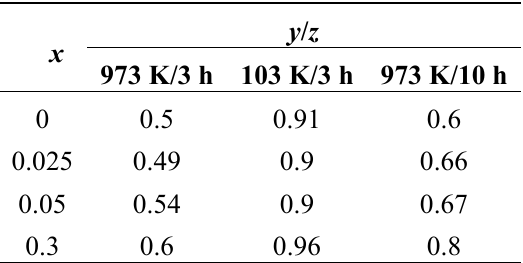
Figure 2. XRD patterns of the samples. ( a ) M10- x Cr-973 K/3 h; ( b ) M10- x Cr-1073 K/3 h; ( c ) M10- x Cr-973 K/10 h. Table 1. X R of M10- x Cr- y K/ z h